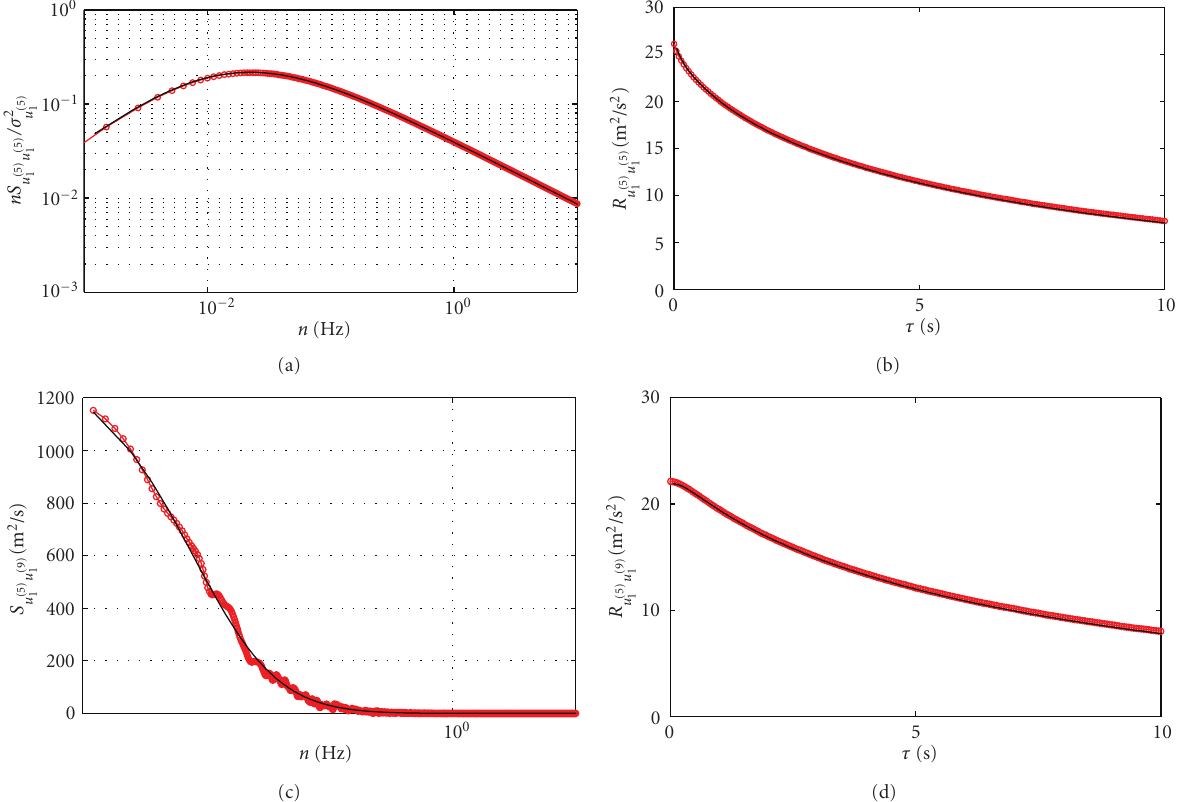
Figure 4: Example 1 using WAWS method for N ω = 2 14 and N t = T 0 / Δ t (i.e., a process duration equal to one period T 0 ; black lines denote target functions, red lines denote numeric approximations): autospectrum of along-wind velocity at point 5 (a); corresponding autocorrelation function (b); cross-spectrum between along-wind velocities at points 5 and 9 (c); corresponding cross-correlation function